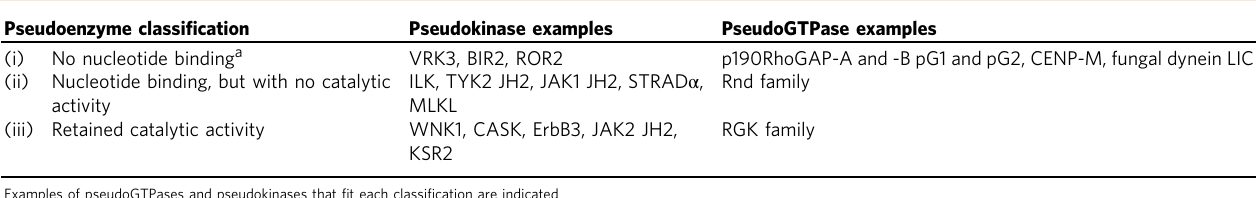
Table 2 Classi fi cation of pseudoGTPases Pseudoenzyme classi fi cation Pseudokinase examples PseudoGTPase examples